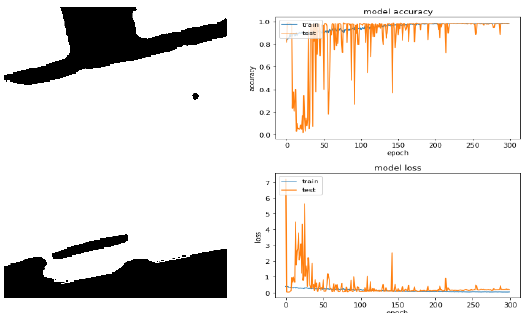
Figure 15 . Test 7 predictions: segmented image, model accuracy, model loss